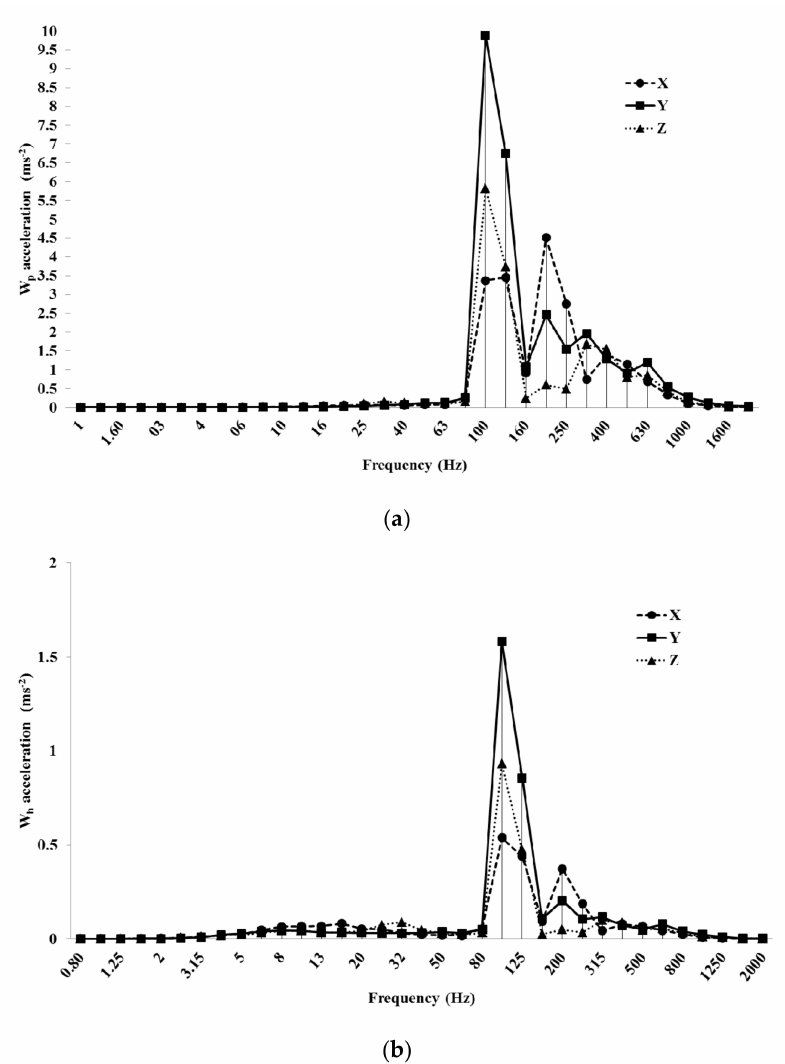
Figure 10. Frequency analysis of acceleration values with W p ( a ) and W h ( b ) weighting curves in the mist blower #2 at HES (high engine speed)